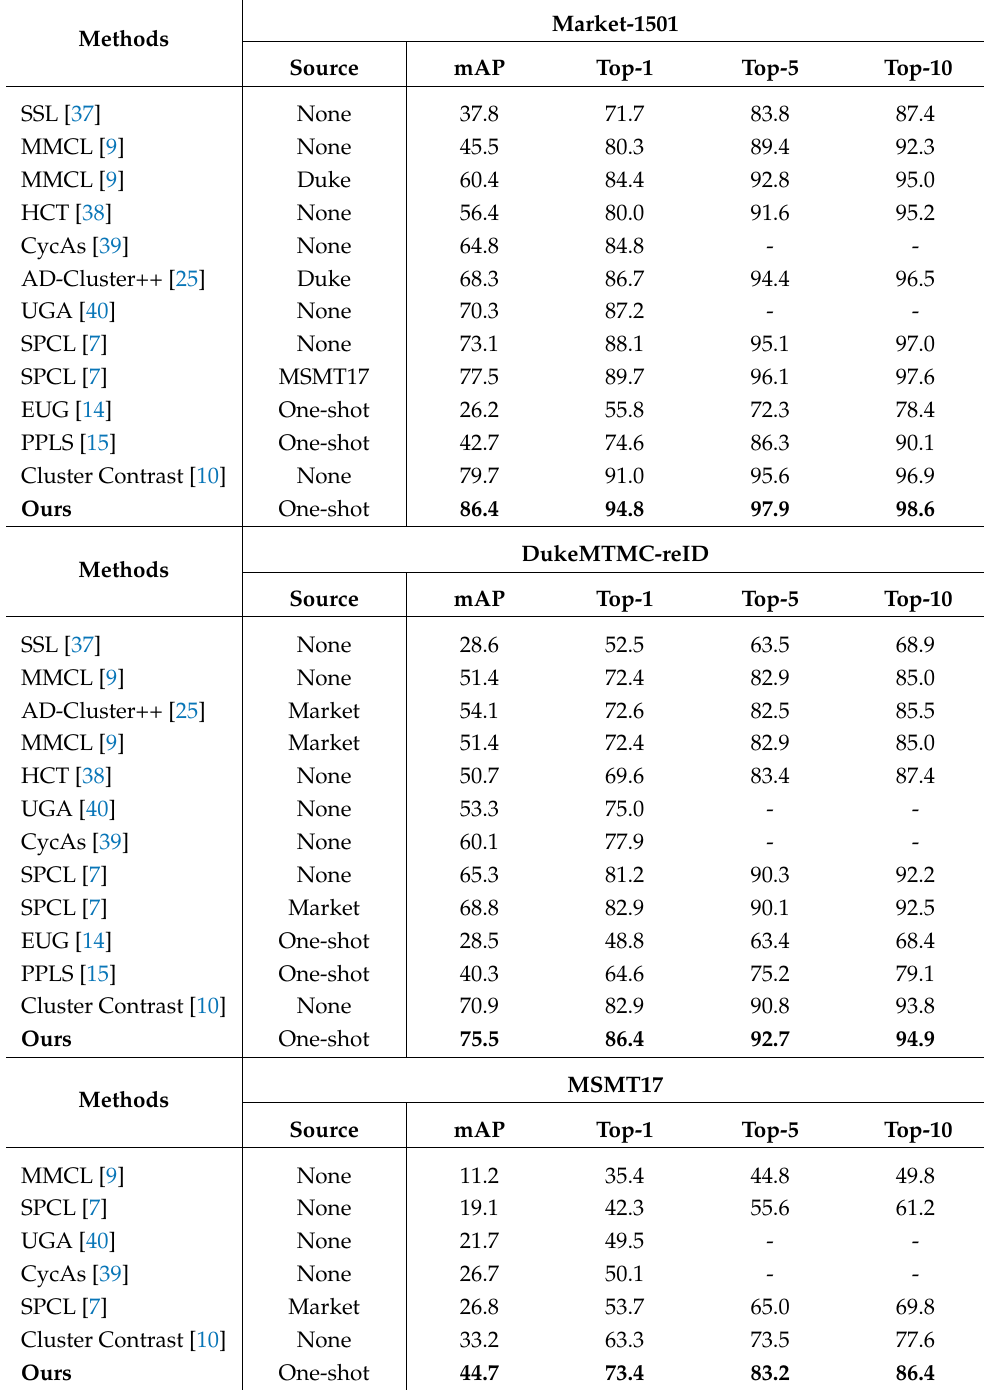
Table 2. Comparison with state-of-the-art methods on the person Re-ID, including one-shot methods, USL methods, and UDA methods. None represents the USL method. One-shot means the one-shot method. The other value represents the source-domain dataset in UDA